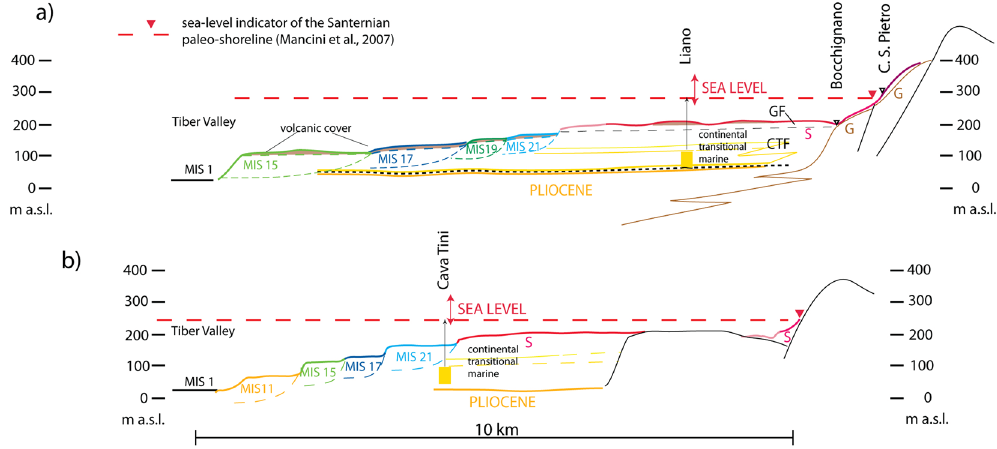
Figure 5. Geologic sections. ( a , b ) Schematic cross-sections reconstructing the geomorphologic and stratigraphic setting on the Tyrrhenian Sea margin of Latium (see location in Fig.